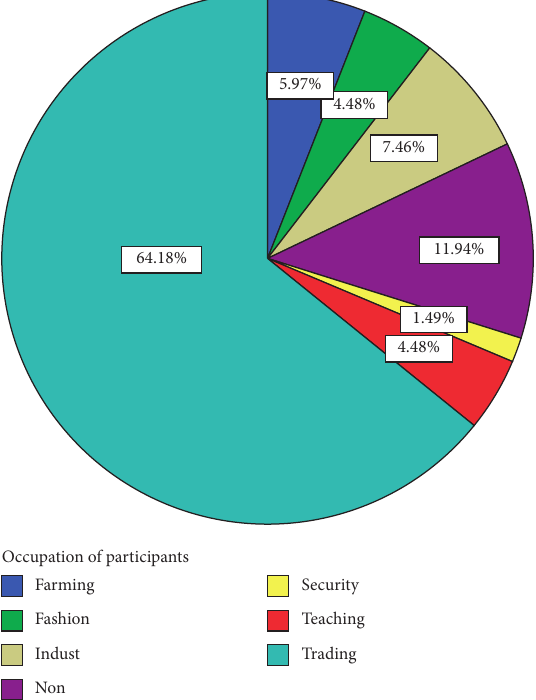
Figure 4: Distribution of occupation of